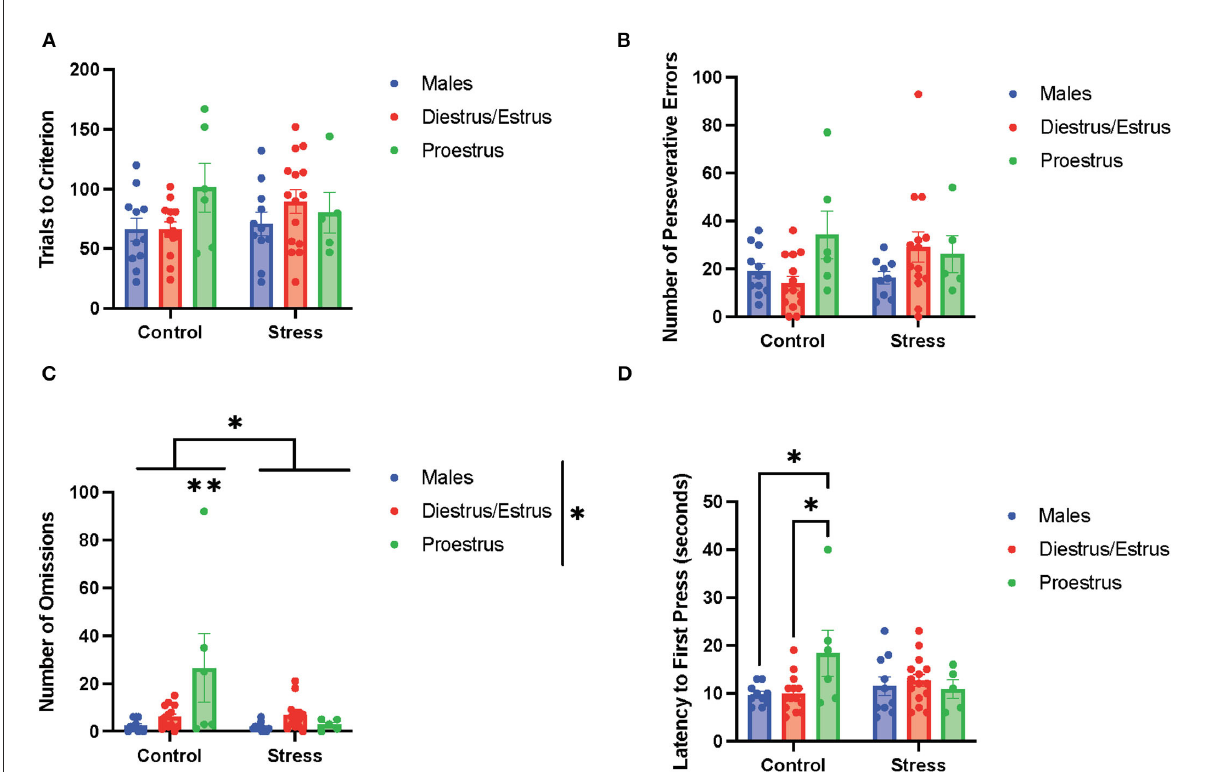
FIGURE6 Gonadal hormone status and acute stress impacted performance in the side reversal task. (A) Gonadal hormone status and acute stress did not affect the trials to criterion. (B) Gonadal hormone status and acute stress did not affect the number of perseverative errors. (C) There was a main effect of stress and gonadal hormone status, and an interaction between the two variables on the number of omissions; this was driven by the most omissions by the control proestrus female rats. (D) There was an interaction between gonadal hormone status and stress on latency to first press. Specifically, the control proestrus female rats exhibited a higher latency to first press than the control male or control diestrus/estrus female rats. Two-way ANOVAs followed by Tukey post-hoc tests were conducted to examine the relationship between stress and gonadal hormone status, and the interaction between the two variables on the measurements of side reversal task performance for the males ( n = 21: control = 11, and stress = 10) and female ( n = 40: control diestrus/estrus = 14, control proestrus = 6, stress diestrus/estrus = 14, and stress proestrus = 6) rats. Error bars are plotted as mean ± SEM. * p < 0.05 and ** p < 0.01.